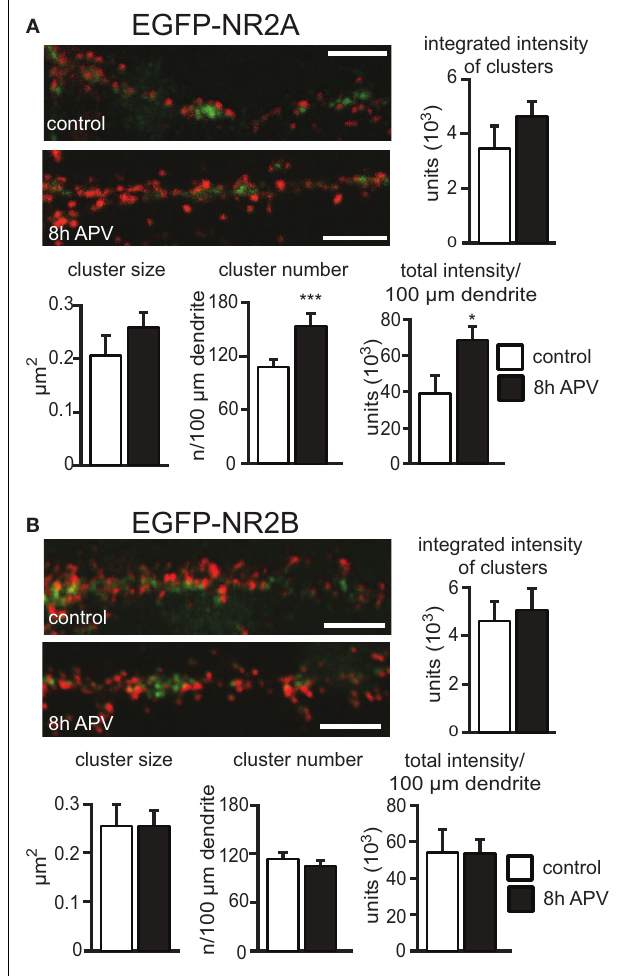
FIGURE 5 | APV treatment increases number and total staining intensity of NR2A but not NR2B clusters. Sample images show EGFP-NR2A (A) and EGFP-NR2B (B) clusters on dendrites of control and APV (8 h) treated cells. Clusters were visualized under non-permeabilizing conditions with an anti- EGFP antibody (red). Intracellular EGFP-NR2A and EGFP-NR2B subunits can be seen in green. Scale bar = 5 µm. (A) Quantifi cation of clusters shows that APV treatment leads to an increase in number and total staining intensity of NR2A clusters (per 100 µm dendrite). There was a trend for an increase in size and integrated intensity of NR2A clusters on cells treated with APV. (B) No difference in any of these parameters could be observed for NR2B clusters, when comparing control and APV-treated cells (mean ±